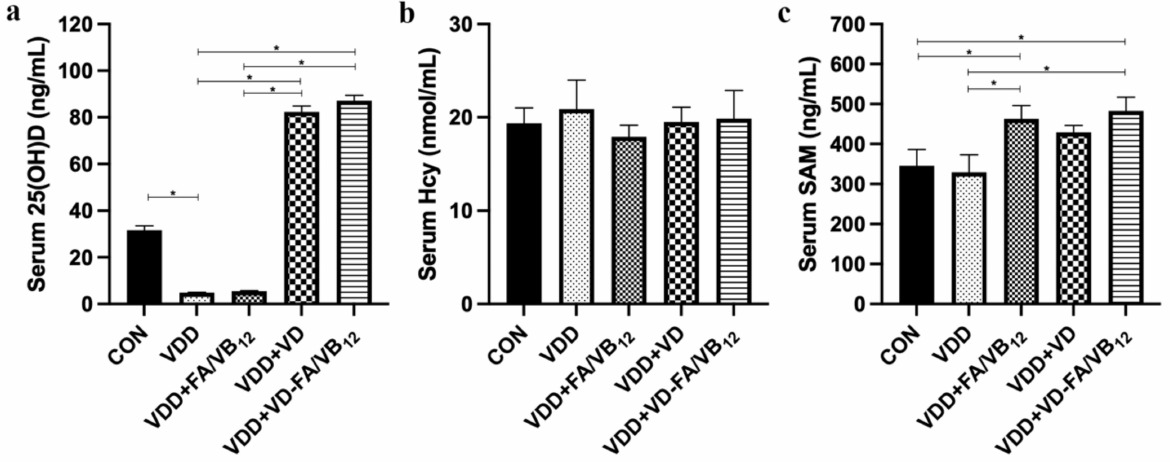
Figure 4. Vitamin D and B vitamins related metabolism levels in serum. ( a ) Serum 25(OH)D level; ( b ) Serum Hcy level; ( c ) Serum SAM level. CON: control; VDD: vitamin D-deficient diet; VDD + FA/VB 12 : vitamin D-deficient diet plus folic acid/vitamin B 12 supplement; VDD +